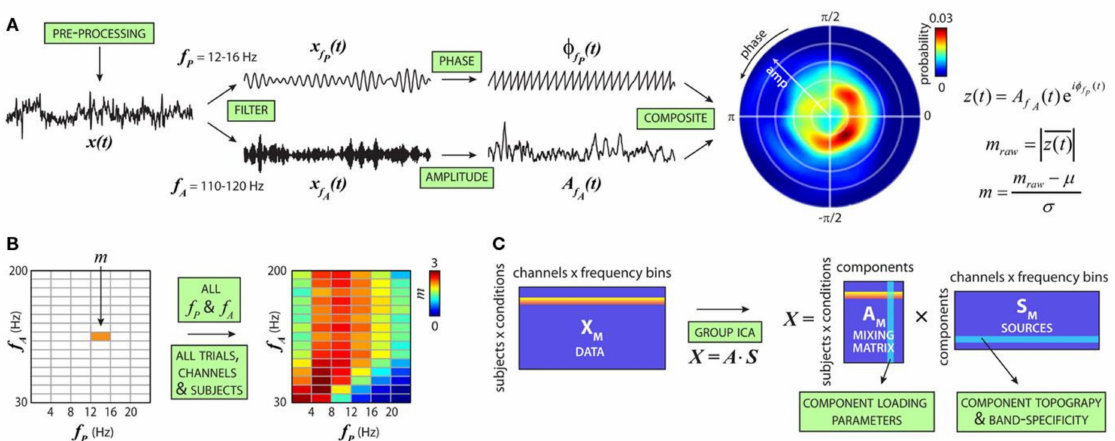
Figure 10. Cross-frequency modulation analysis. ( A ) Steps to compute the cfM index (m). ( B ) Steps in ( A ) are repeated for all fP and fA combinations to produce the comodulogram. ( C ) For each subject, comodulograms are averaged over trials. A single row for each condition is generated by merging data from all channels (reproduced with permission from [171]).